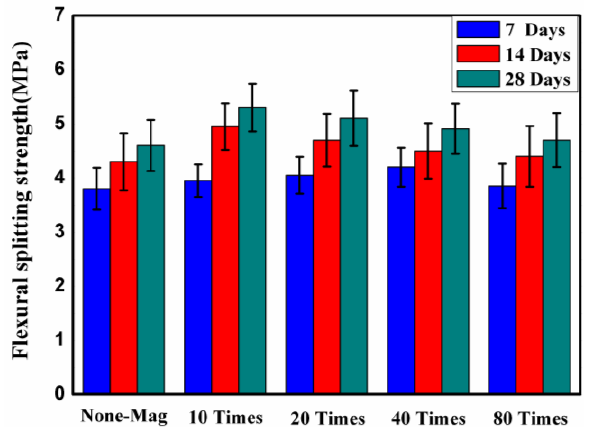
Figure 7. Flexural strength of concrete block pavers after 7, 14, and 28 days of curing in lime-saturated water.